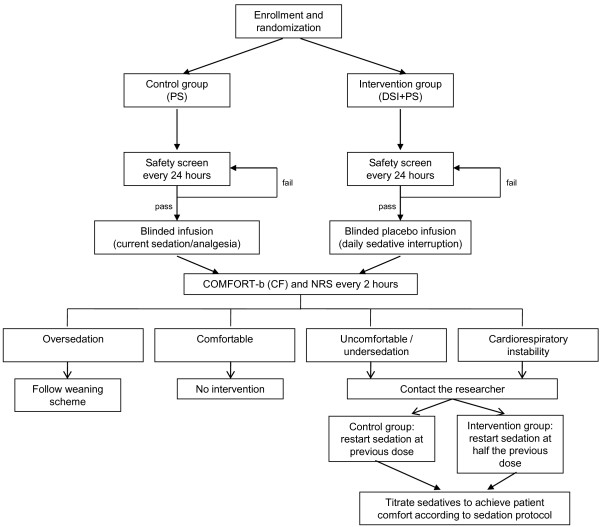
Flowchart of study design.